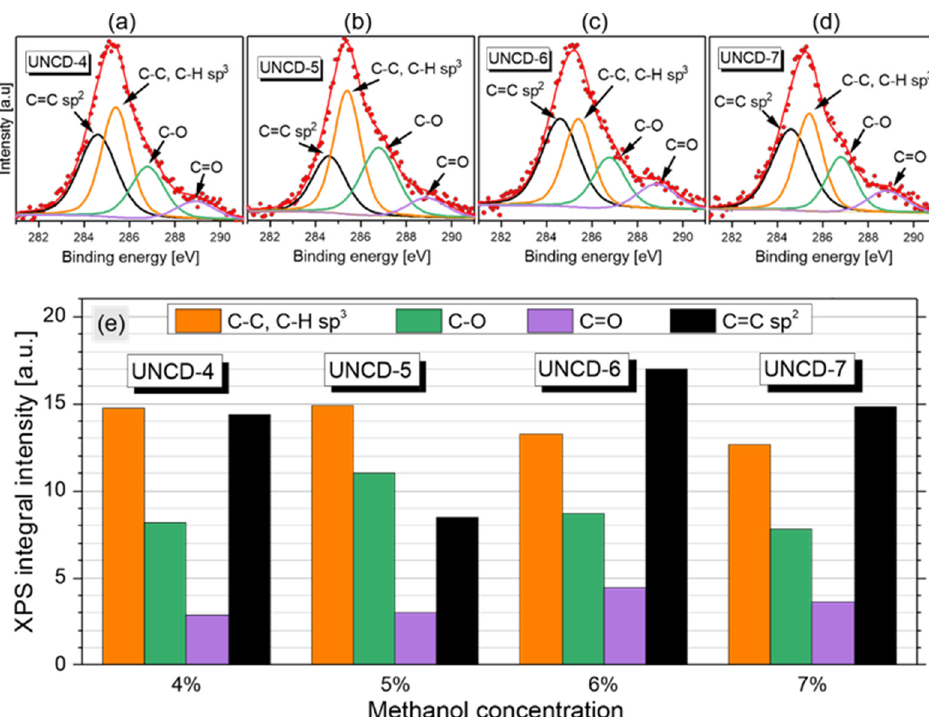
Figure 6. ( a – d ) XPS spectra of C 1s peak of UNCD films grown at different methanol concentrations. ( e ) Comparison of the results of C 1s peak deconvolution with quantification of different carbon bonding states.